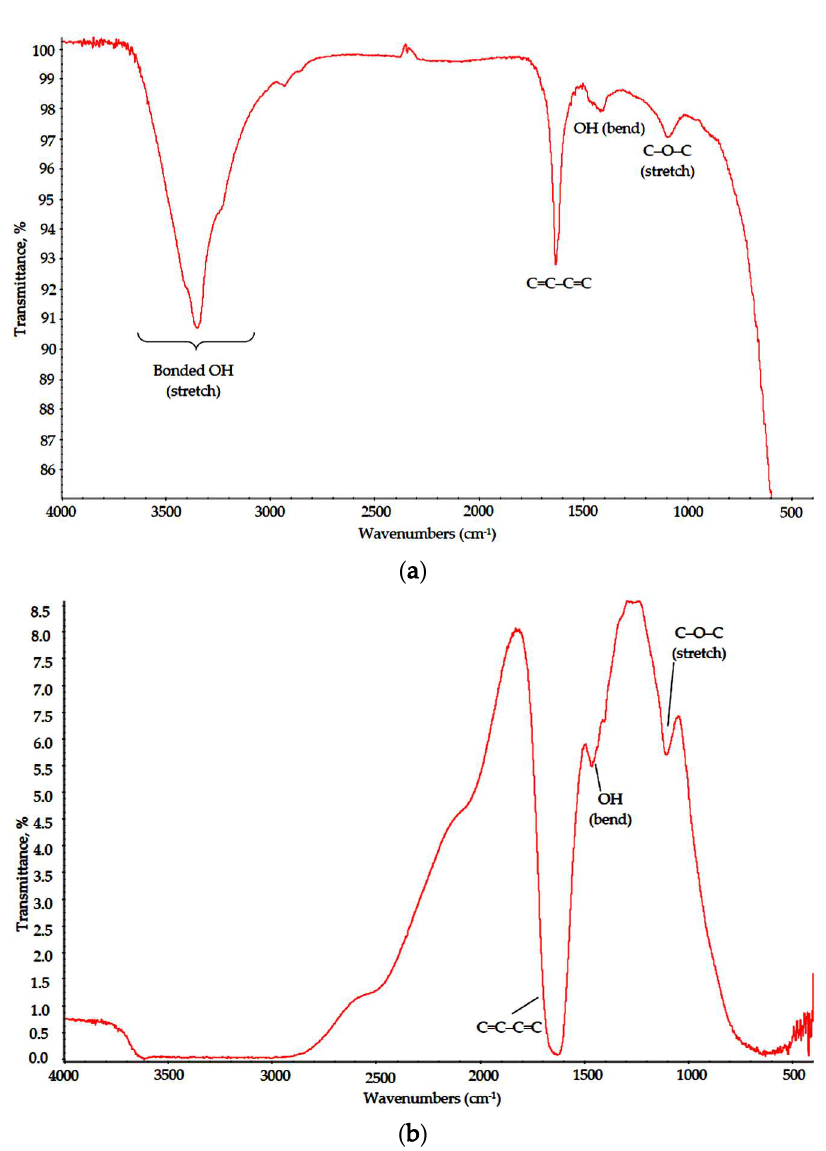
Figure 5. IR spectra of (a) PVA–CAY and (b) PVA–MAY powders.